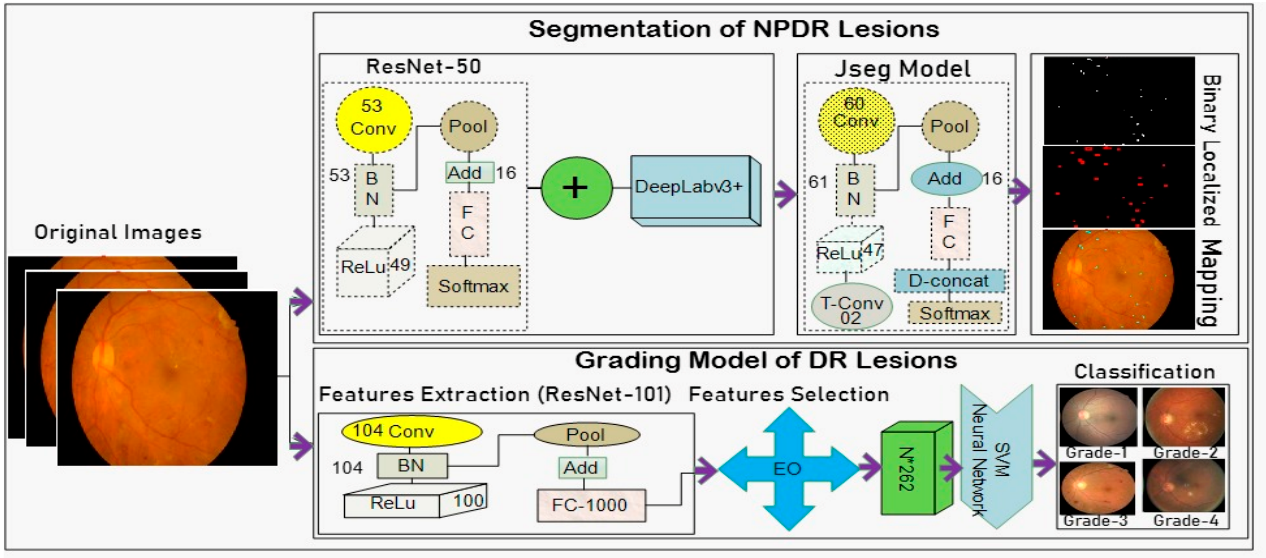
Figure 4. DR identification process [21] .